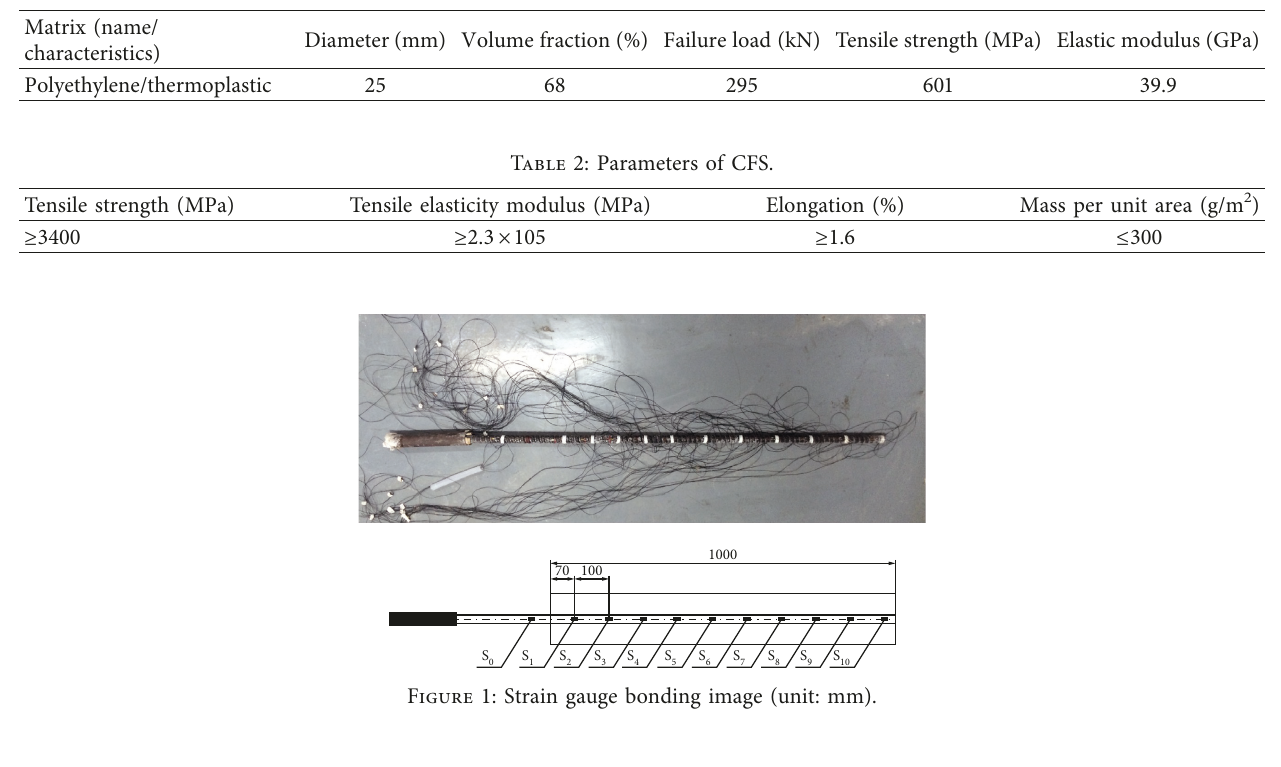
Table 1: Parameters of GFRP